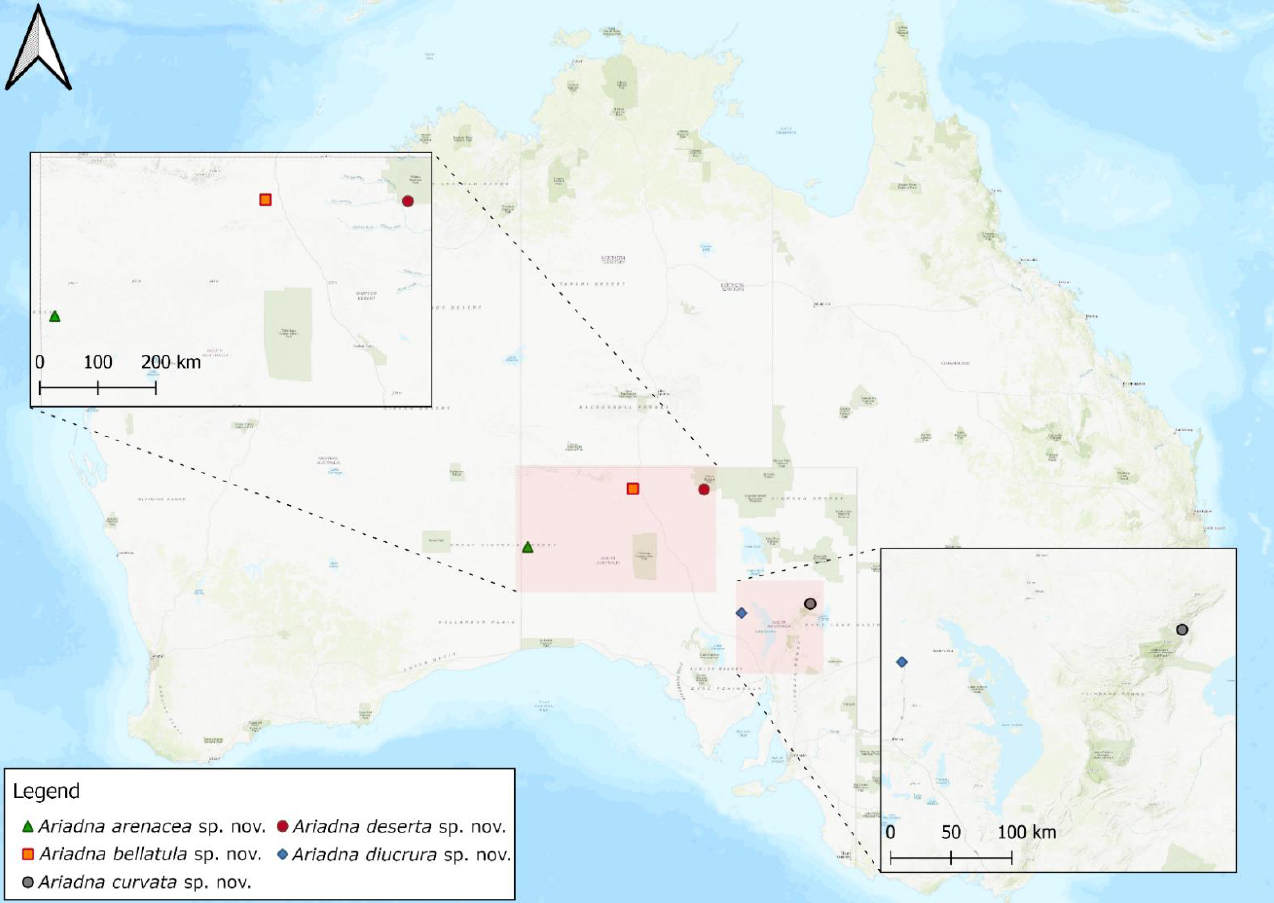
Figure 28. Map showing the currently known distribution of A. arenacea sp. nov. , A. bellatula